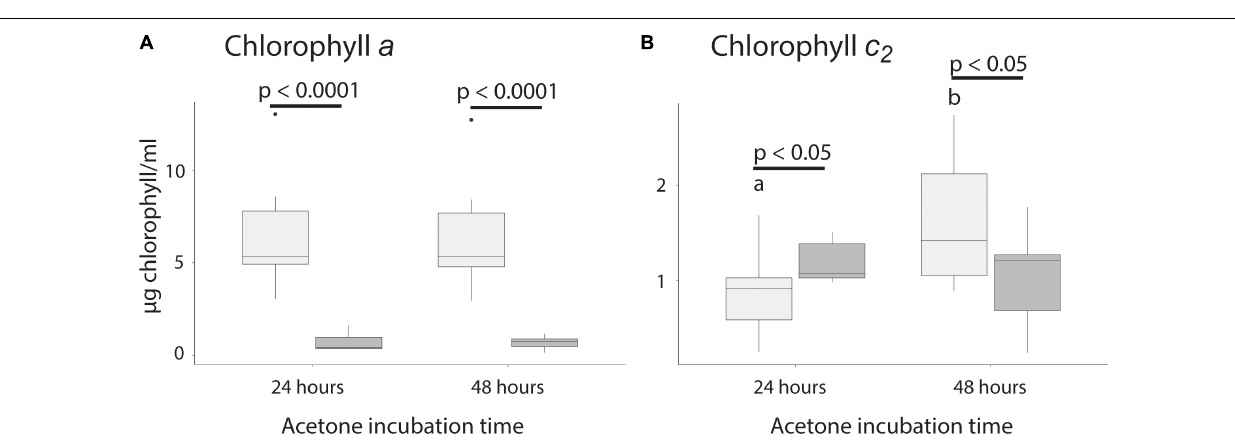
( Figure 1C ). Chlorophyll c 2 concentrations of Cladiella sp.